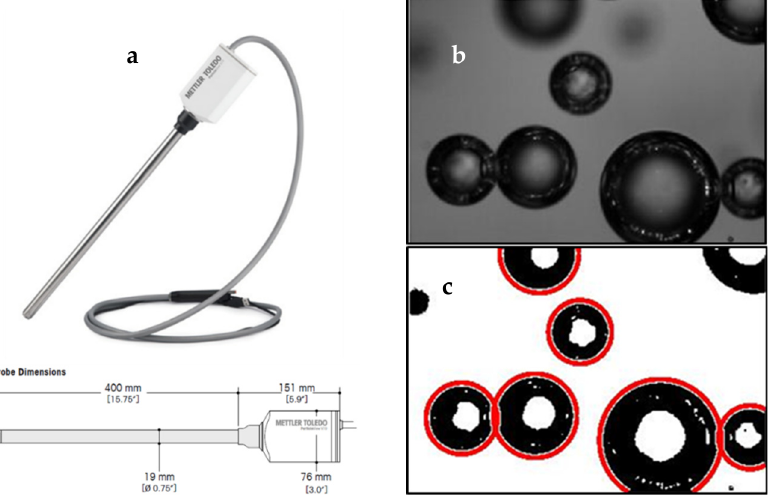
Figure 4. ( a ) PVM probe, ( b ) captured bubble images and ( c ) bubble segmentation, image size 1.30 × 0.89 mm.